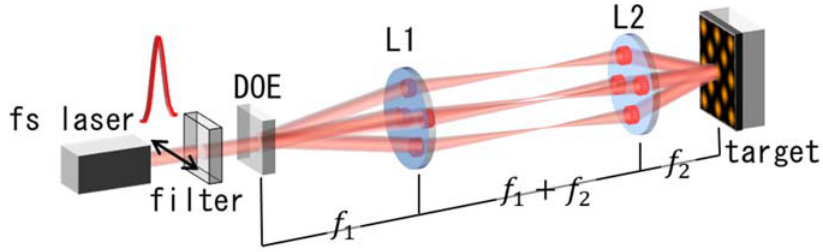
Figure 1. Experimental setup. The pulse width of the laser was 240 fs and the wavelength was 785 nm. DOE (diffractive ‐ optical element) split four 1st order diffracted beams. (cid:1858) (cid:2869) (cid:3404) 300 mm and (cid:1858) (cid:2870) (cid:3404) 40